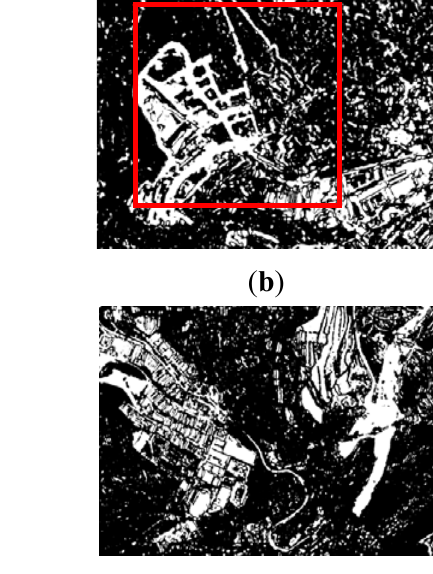
Figure 8. Level 3 thresholded indices: best results ( a ) Area A1: CVA Index-Yen method (binary image); ( b ) Area A1: CVA-Text-Hom.–Li method (binary image); ( c ) Area A2: CVA Index–Yen method (binary image); ( d ) Area A2: CVA-Text-Hom.–Li method (binary